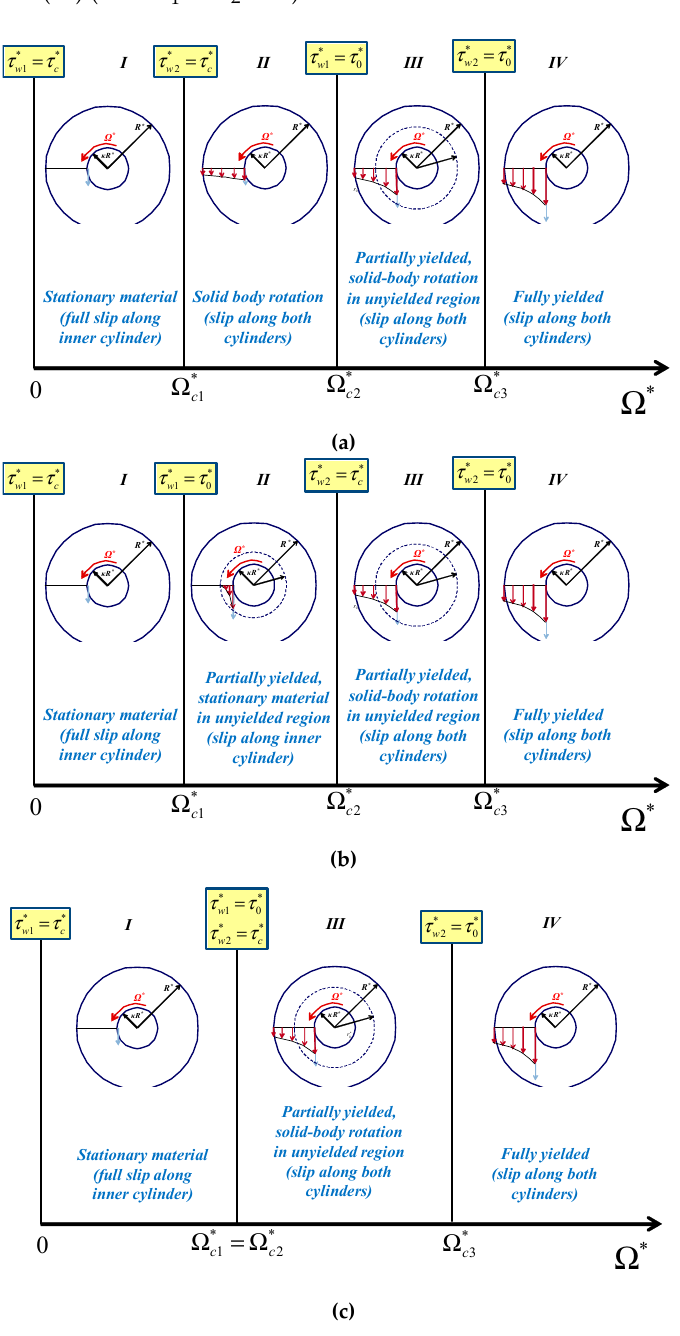
Figure 14. Flow regimes in circular Couette flow of a Bingham plastic when the inner cylinder is rotating with non-zero slip yield stress such that τ ∗ c < τ ∗ (the second regime is not observed). It should be noted that τ ∗